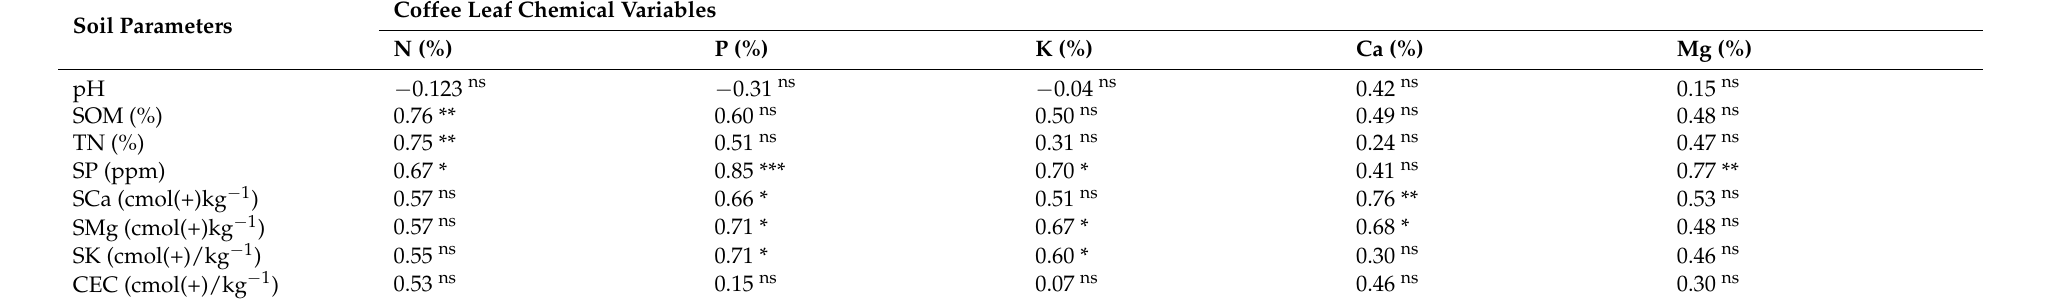
Table 6. Correlation between soil and coffee leaf chemical variables.